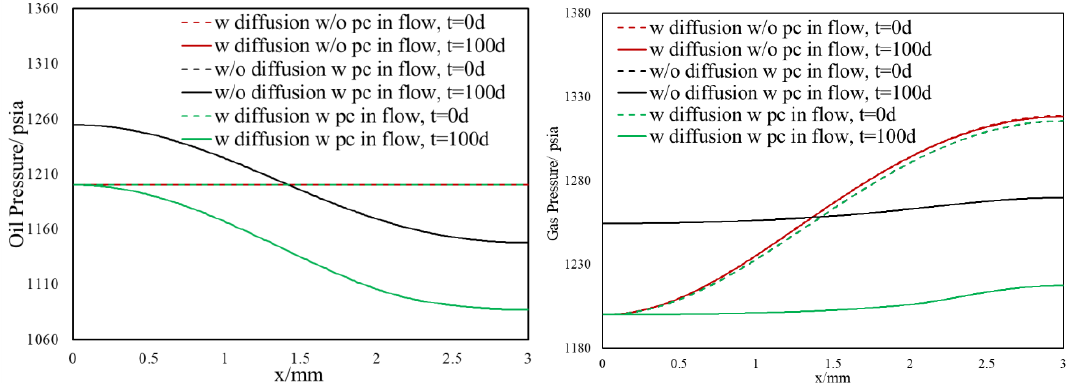
Figure 21. ( a ) Methane composition in gas phase ( b ) Butane composition in the liquid phase ( c ) Oil saturation profile, results are without Pc in flow and with diffusion, ternary mixture.